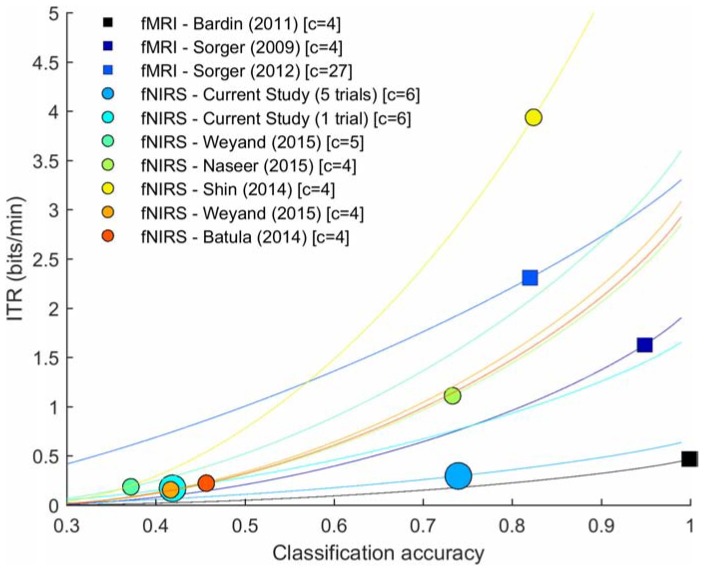
Average ITR values from relevant hemodynamic-BCI literature. Square markers represent fMRI-based BCIs, while circular markers represent fNIRS-based BCIs. Lines depict the theoretical values the ITR (bits/min) can take as a function of the number of classes (c), trial duration and accuracy.